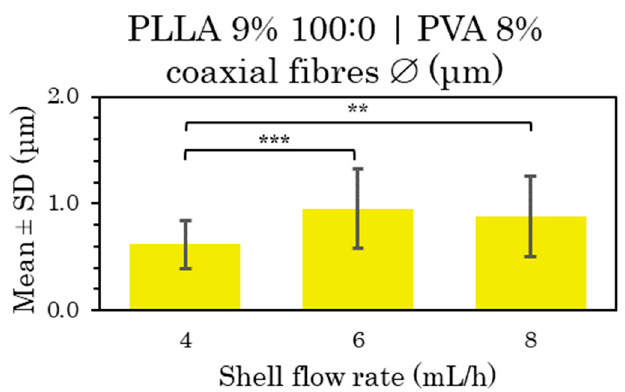
Figure 11. Mean and standard deviation of the diameters of 9% PLLA 100:0 (shell) and 8% PVA (core) coaxial microfibers manufactured at 4, 6 and 8 mL/h shell flow rate with 15 cm and 15 kV. Core flow rate 0.5 mL/h in both cases, at (**) p < 0.01, (***) p < 0.001 statistically signi fi cant di ff erences.